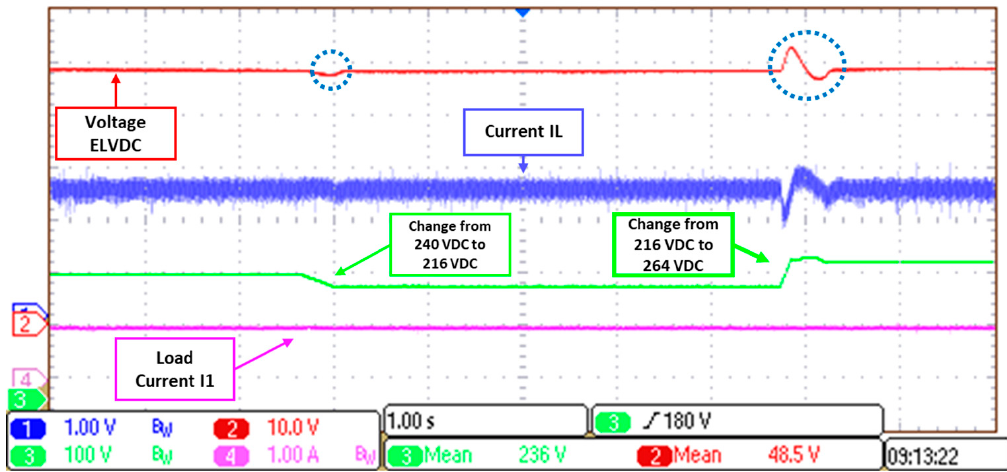
Figure 20. Experimental waveforms during validation of line regulation in buck mode.